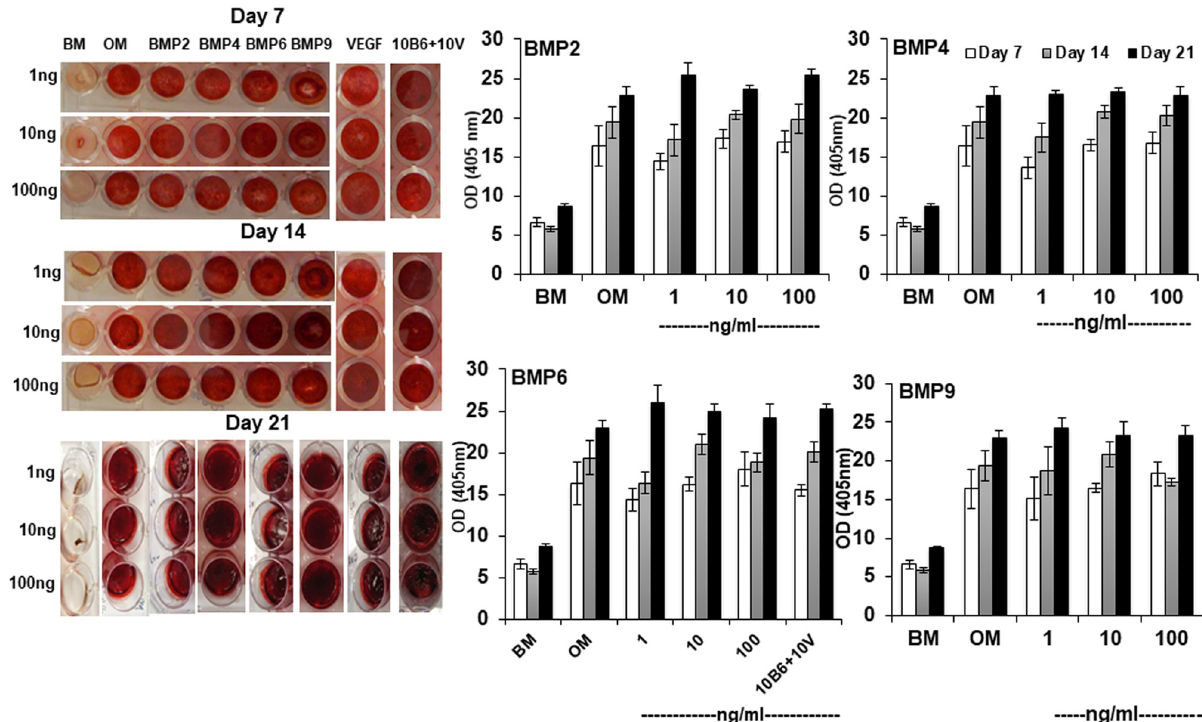
Fig 1. BMPs do not enhance mineralization. The mineralization of D1 cells was measured quantitatively using alizarin red staining. The cells were stained at day 7, 14 and 21 using alizarin red (left panel). The dye was extracted and intensity of color was quantified at 405 nm using a spectrophotometer (right